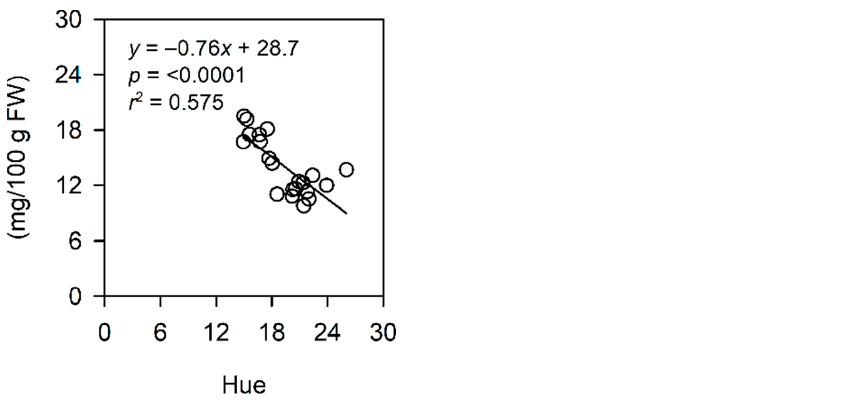
Figure 5. Linear regression between berry hue and anthocyanin content of ‘Florida Radiance’ straw- berry. Data from the 2015–16 and 2016–17 seasons are included in the figure. The correlation was considered significant when the slope was significantly different from zero ( p ≤ 0.05).